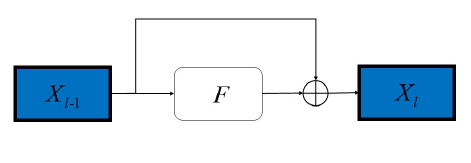
Figure 3. Structure of residual